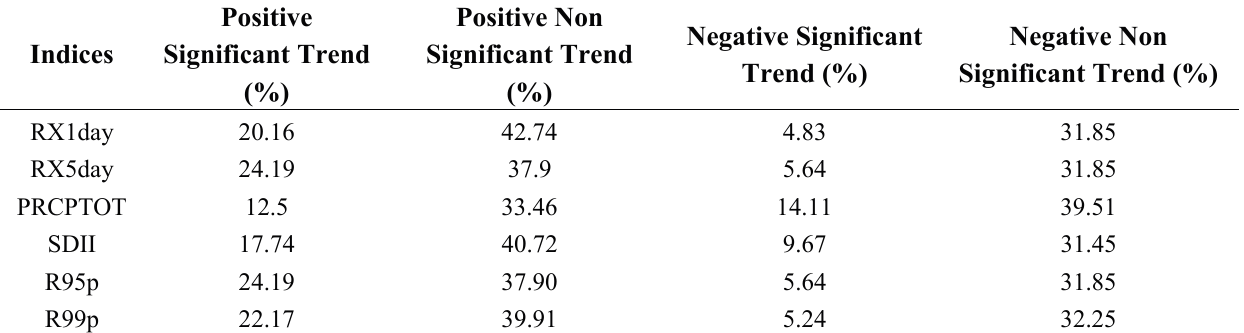
Figure 15. The most significant negative trend with a slope of − 0.0681 ( left ) and the most significant positive trend with a slope of 0.0903 ( right ) of the SDII index. Table 3. Percentage of significant and non-significant trends of intensity